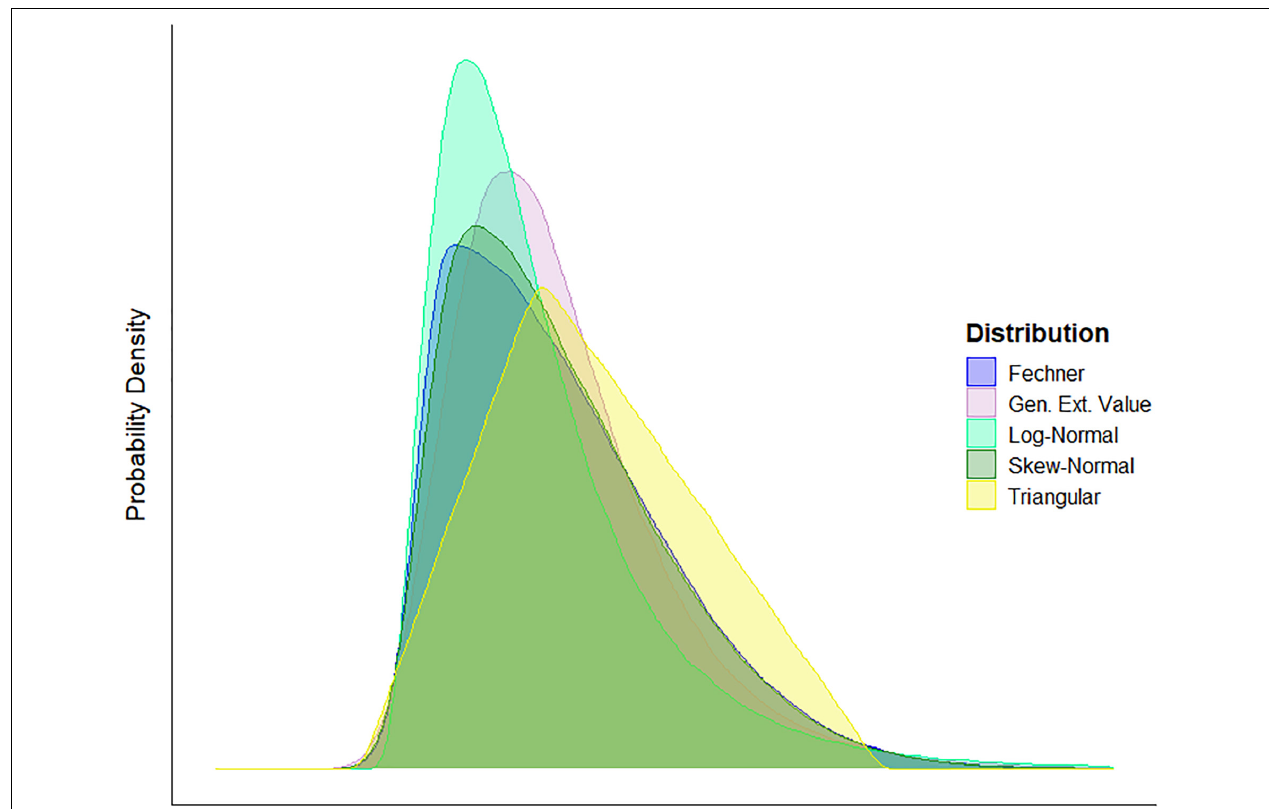
FIGURE 1 | Comparison example of the probability distributions considered in the present study, fitted to a common emission